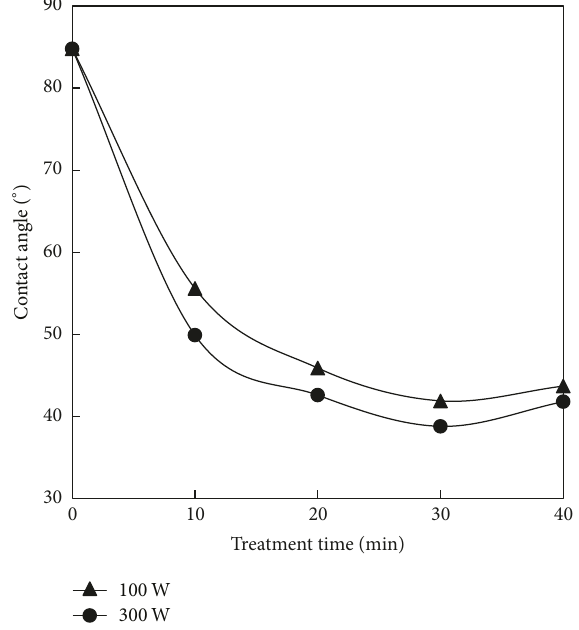
Figure 2: Dependence of the surface contact angle upon UV power and the treatment time at the TiO 2 content of